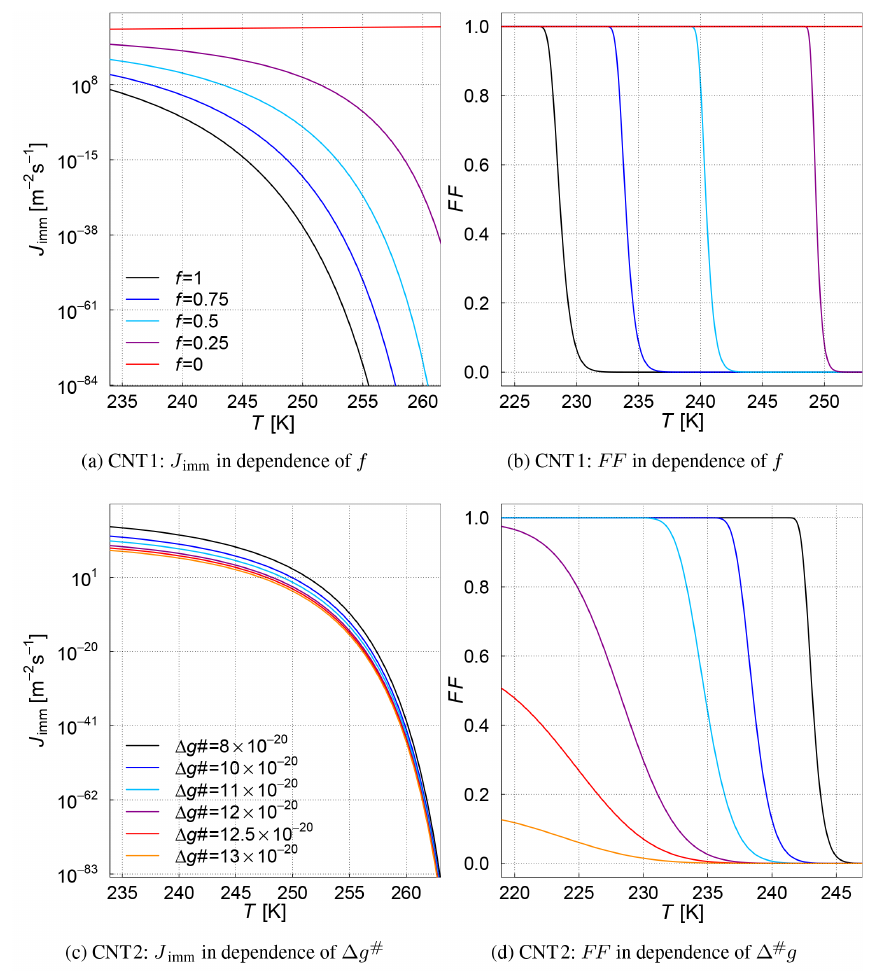
Figure A1. Nucleation rate J imm and frozen fraction FF in dependence of the fit parameters for the contact angle schemes 1 and 2 ( f and (cid:49)g # ). To estimate FF we assume an aerosol particle diameter of 400nm and a timestep of 10s. In case of the single- α R&D + fit (cid:49)g # scheme (No. 2) the geometric term f was chosen to be 0.3. The dependence of the formulation (in the case of a fixed (cid:49)g # ) on f is the same as with the single- α R&D + Z formulation (No. 1). Decreasing f (reducing the energy barrier) shifts the freezing curve to higher temperatures while the slope slightly increases. Increasing (cid:49)g # shifts the freezing curve to lower temperatures and changes the slope of the freezing curve. A higher activation energy barrier leads to a flattening of the